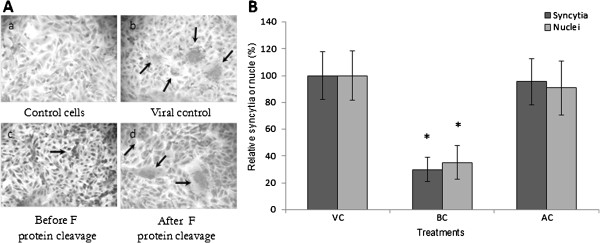
Inhibition of avirulent NDV (La Sota) strain-mediated cell fusion. A) Vero cells infected with NDV and treated by trypsin digestion: a) Uninfected control cells; b) Vero cells infected with NDV and treated with trypsin; c) Infected Vero cells were treated with fucoidan before F protein cleavage, at which point syncytia formation could be inhibited if fucoidan was added; d) Infected Vero cells were treated with fucoidan after F protein cleavage, and fucoidan could not inhibit syncytia formation in this condition. B) Fusion inhibition assay with fucoidan treatment before (BC) and after F protein cleavage (AC). Data are expressed as percent of the number of syncytia and syncytial nuclei compared with the findings in untreated virus-infected control cells. VC, viral control. The data shown are the mean ± SD of triplicate experiments. The asterisks indicate a significant difference between the treatment and viral control (*p<0.05).